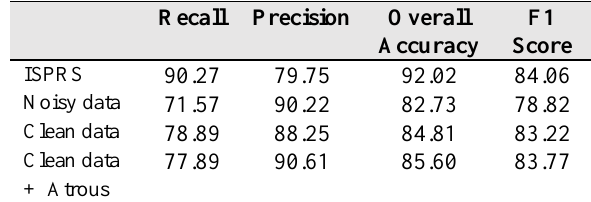
Figure 11. The learning rate of ISPRS dataset